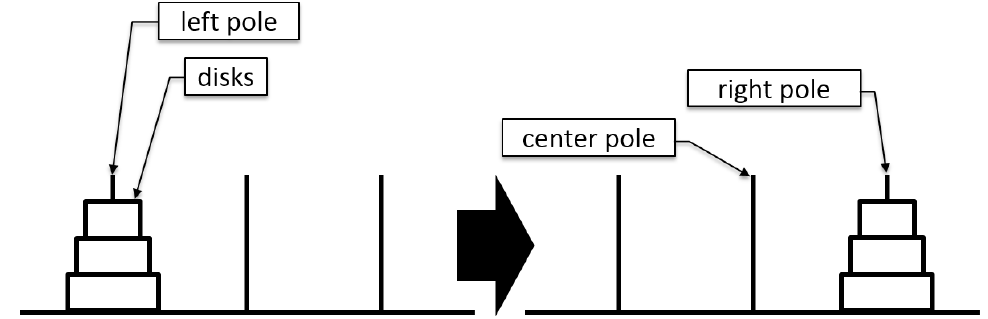
Figure 1. The ToH experimental